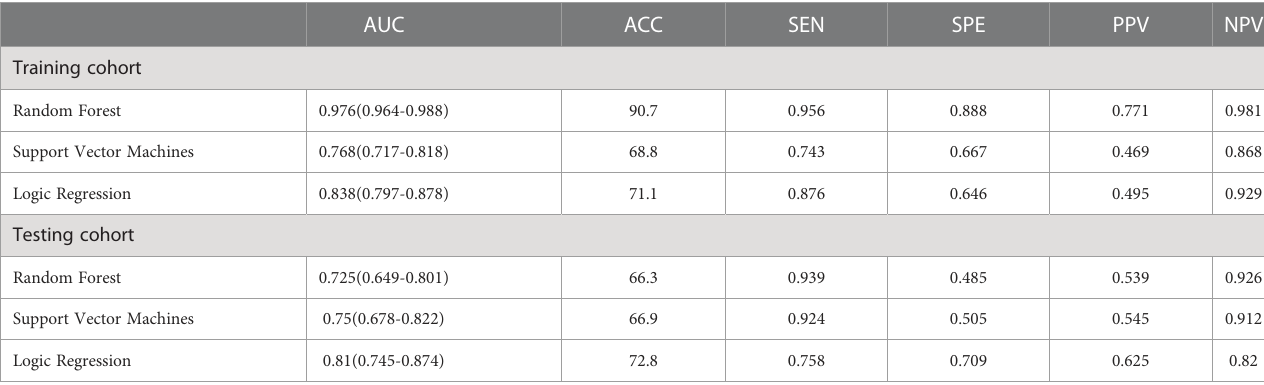
TABLE 2 Performance of the three model in the training and testing